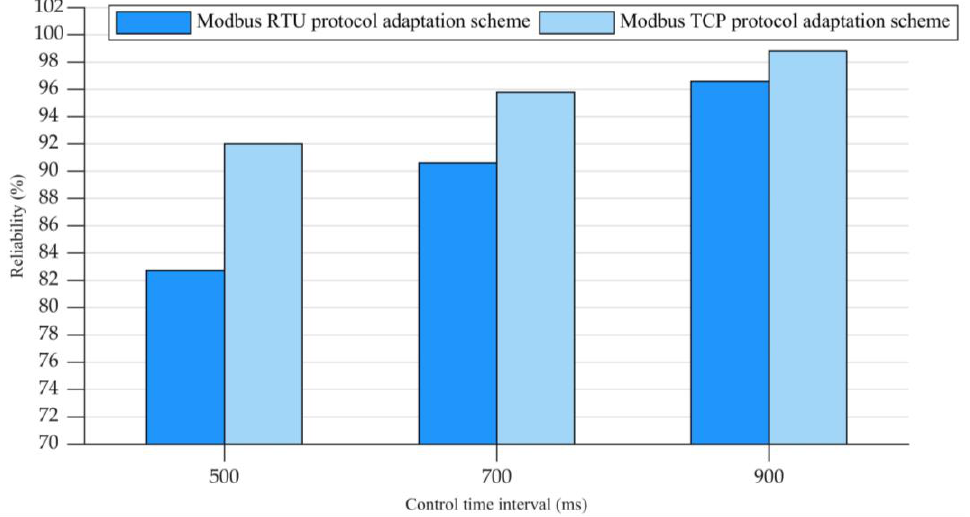
Figure 21. The reliability comparison between Modbus RTU and Modbus TCP for protocol adapta- tion.